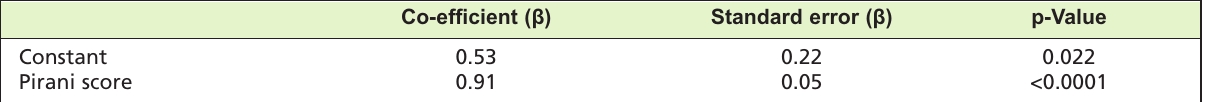
Regression model analysis showing coefficients in the regression line with their standard error and significance. Table I: Age was dropped out of the model